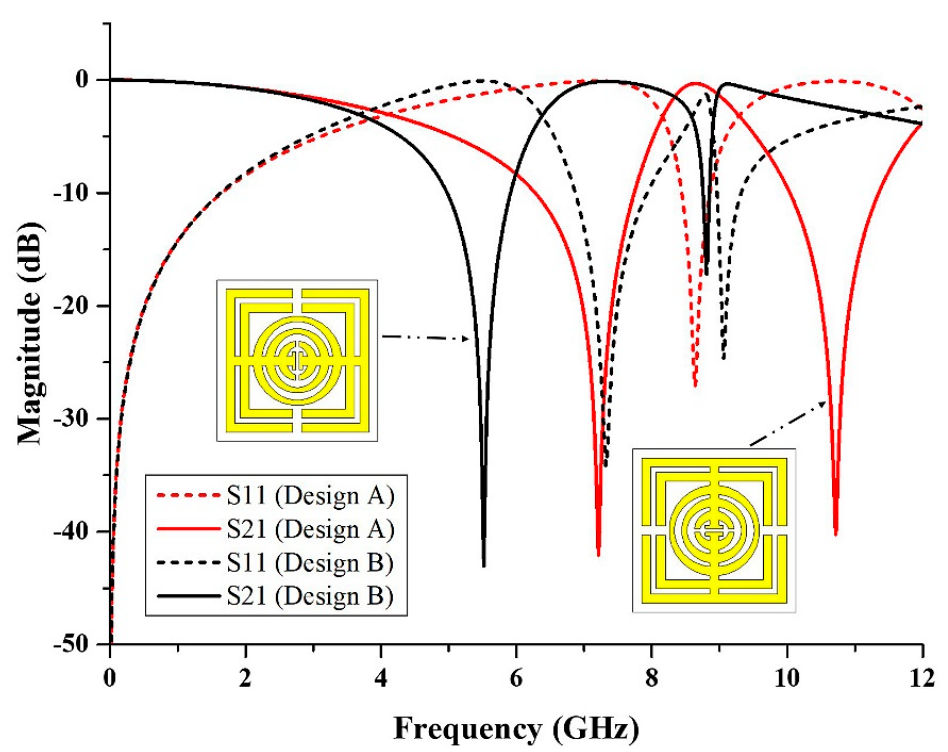
Figure 13. The comparison of S-parameters for design A and design B.